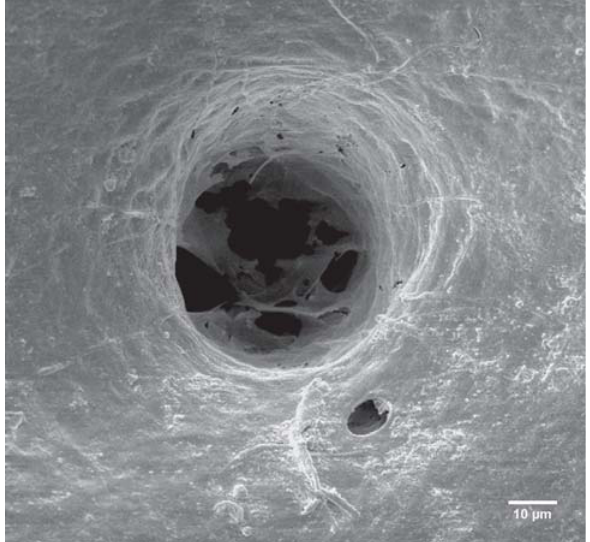
FIGURE 3- Severe club shape hypercementosis. Root apex of a maxillary molar, showing the presence of 2 apical foramina. Original magnification: